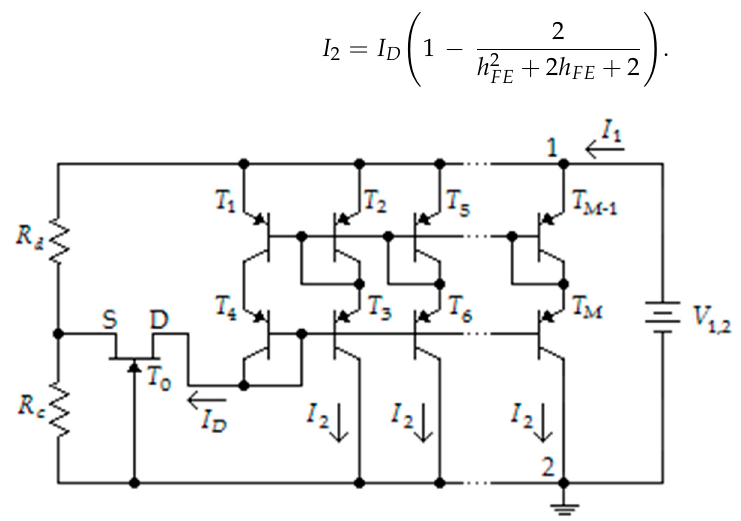
Figure 4. Two-terminal NDR circuit with multiple-output Wilson current mirror.